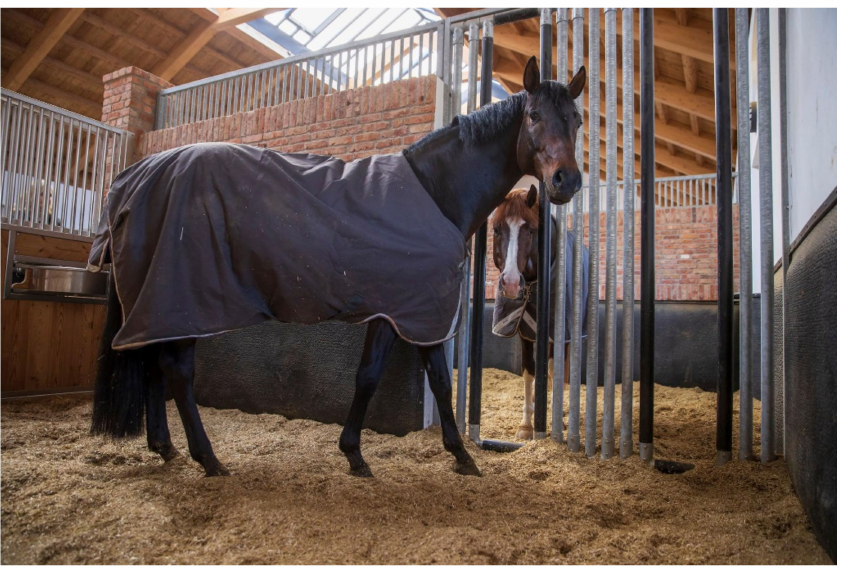
Figure 3. Socialbox. Gut Schönweide, Germany (Breeding Stallions Follow Him’s Schönweide und